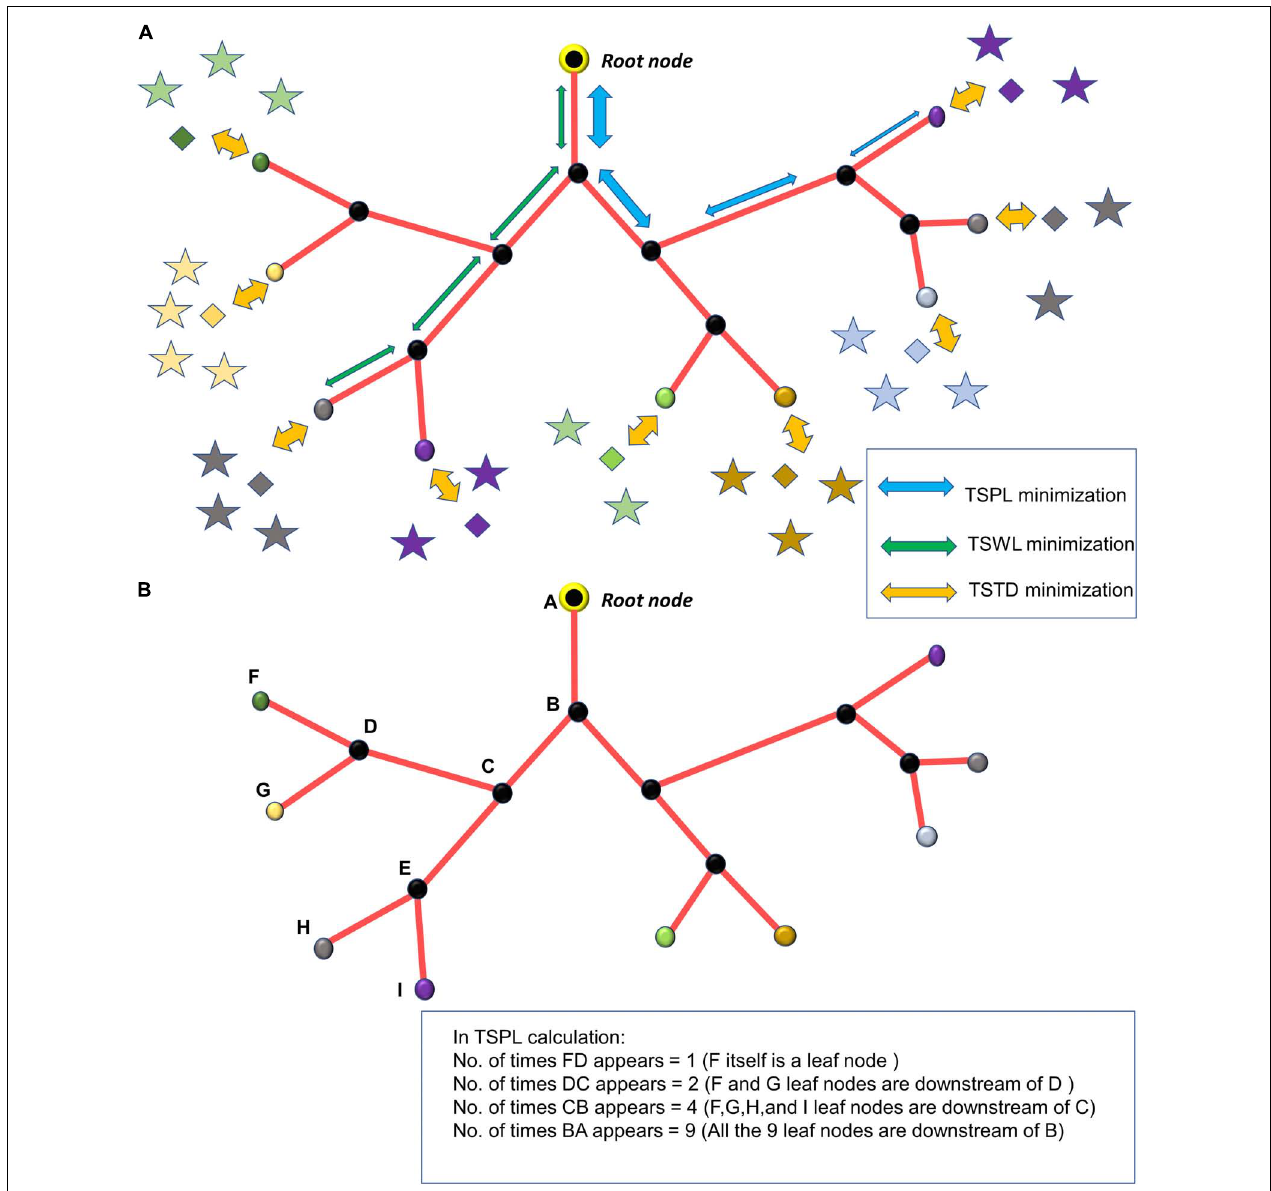
FIGURE 1 | (A) The minimization of TSPL, TSWL, and TSTD shown in the vascular tree; (B) estimation of n_j, the number of leaf nodes downstream of the vascular node, j.